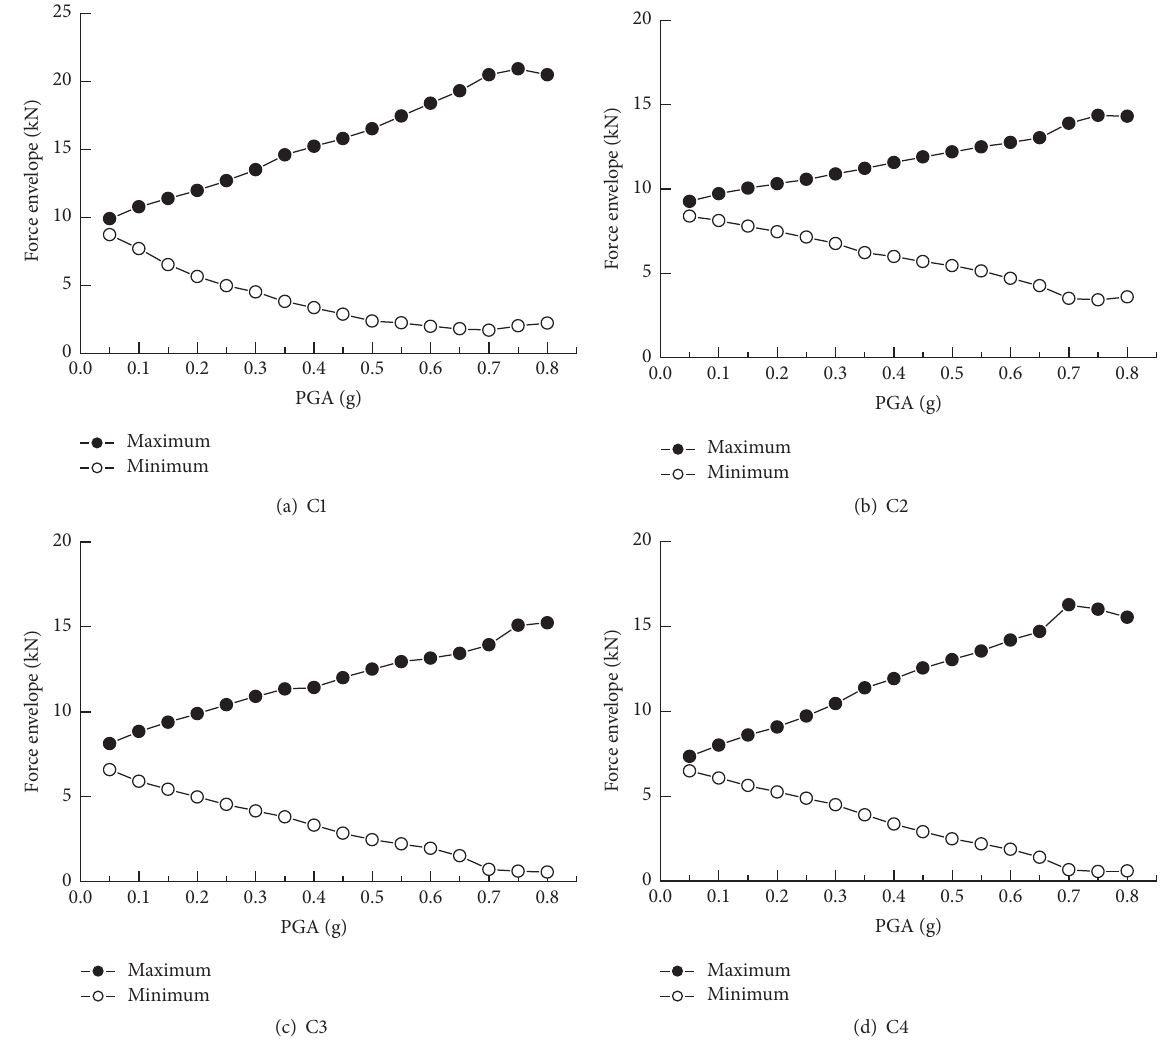
Figure 11: Cable force envelope of test